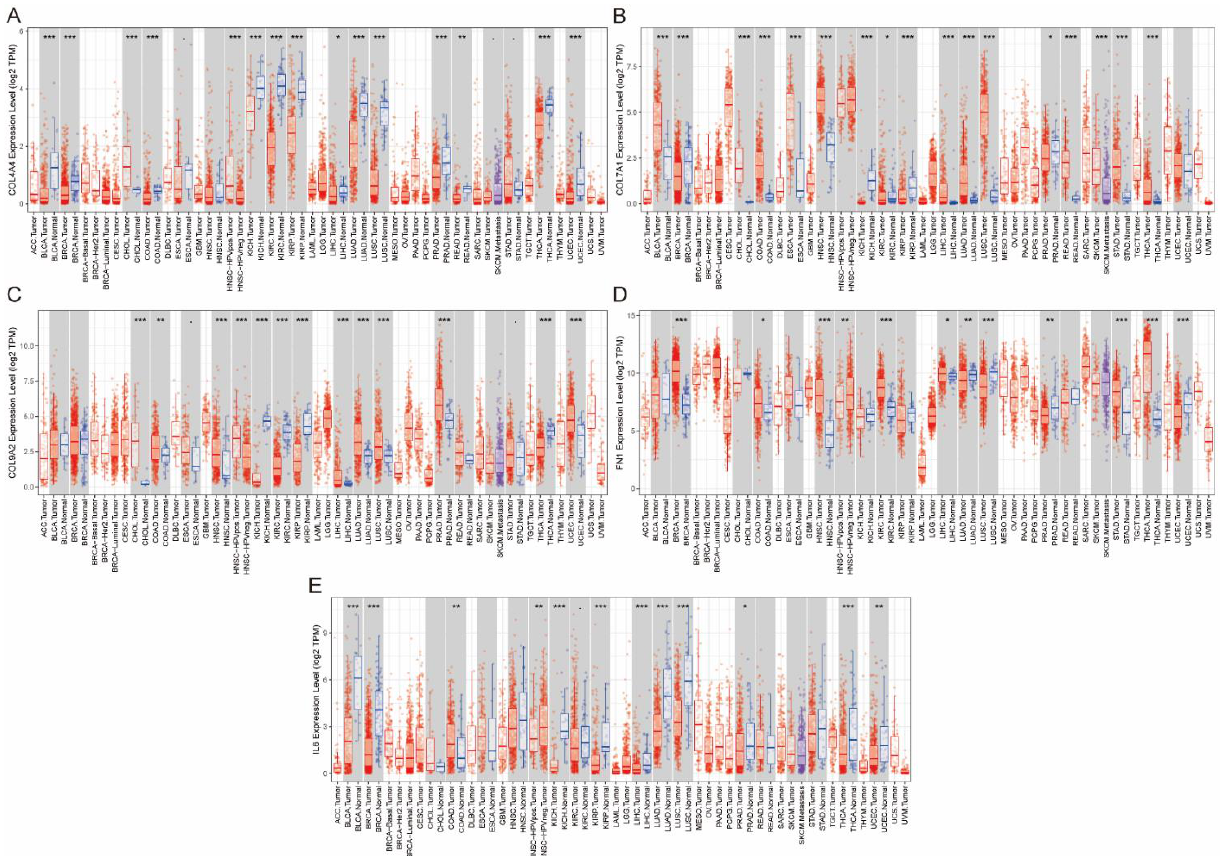
Figure 2. The gene expression profiles of five collagen-related genes in pan cancer based on TIMER database. ( A – E ) The differential expression between tumor and adjacent normal tissues for five collagen-related genes including COL4A4, COL7A1, COL9A2, FN1, and IL6 across all TCGA tumors. Distributions of gene expression levels are displayed using box plots, with statistical significance of differential expression evaluated using the Wilcoxon test. * p < 0.05, ** p < 0.01 and *** p < 0.001.